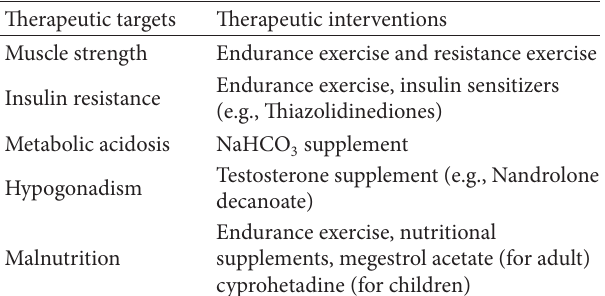
Table 1: Therapeutic interventions for muscle wasting in hemodial- ysis